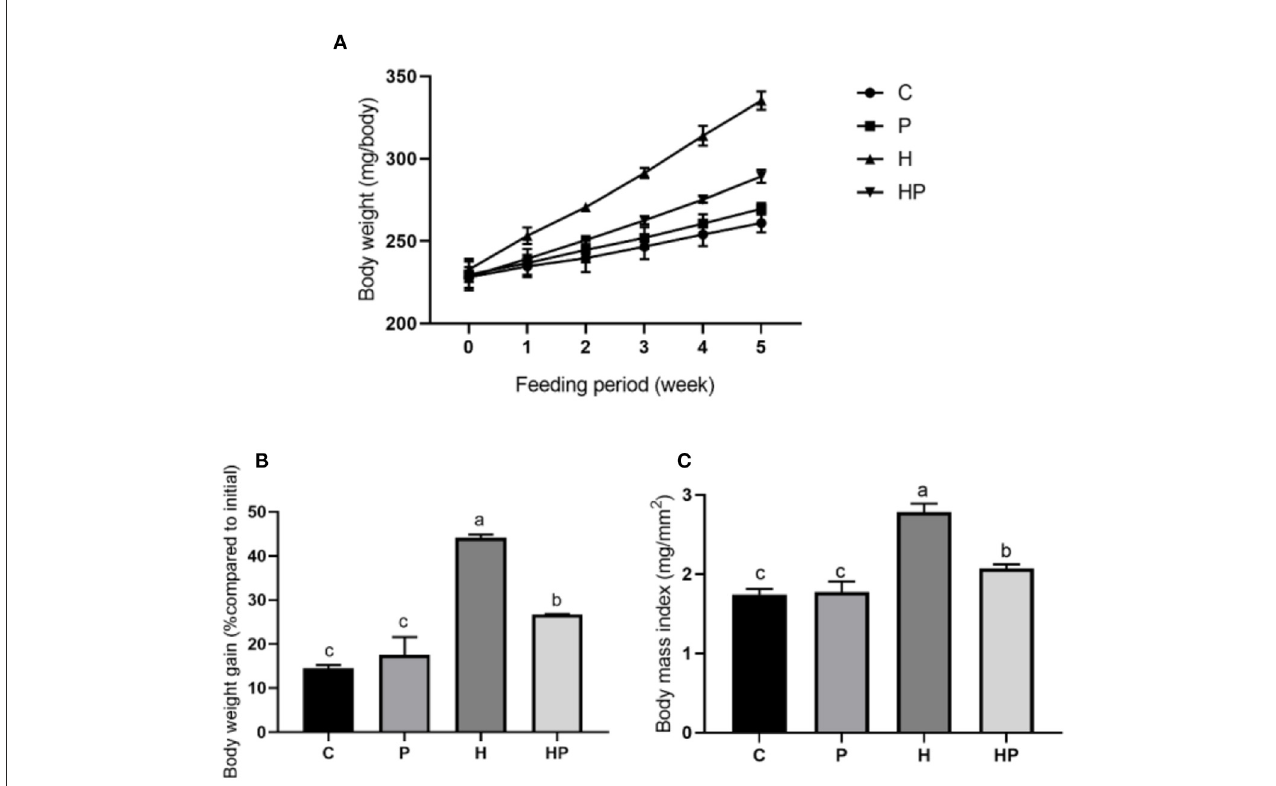
FIGURE1 Changes in body weight and BMI in zebrafish on the different diets. (A, B) Changes in body weight during 5 weeks. (C) BMI in adult zebrafish after 5